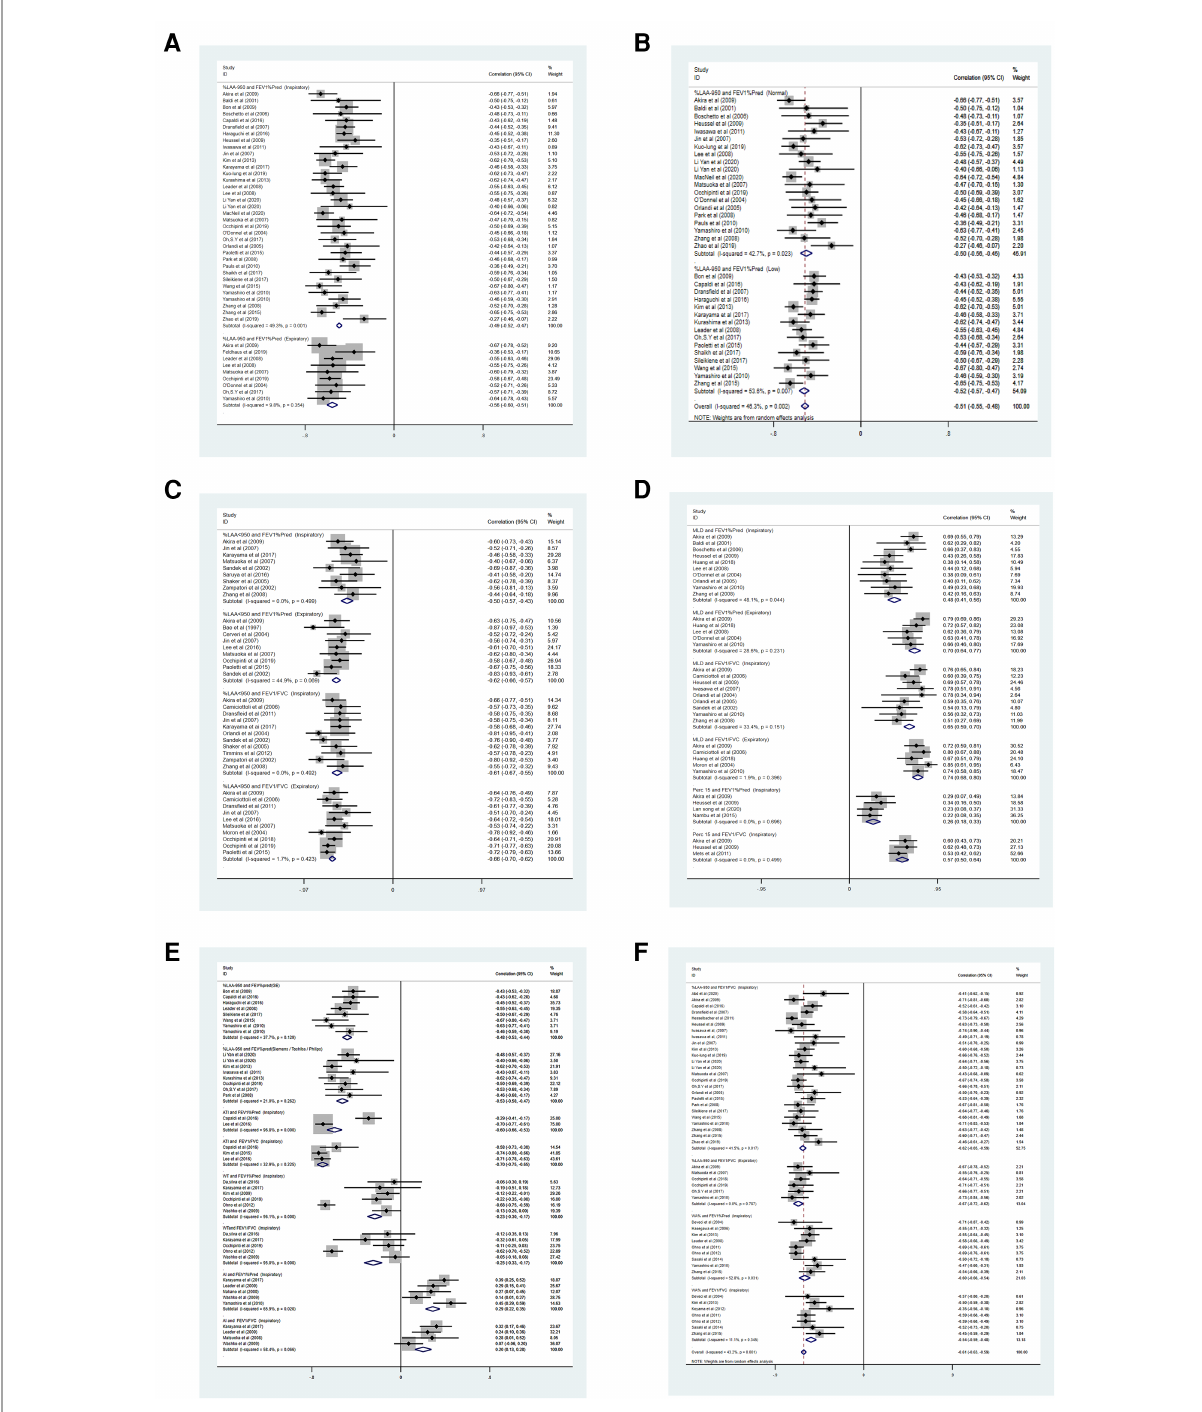
FIGURE 4 ( A – F ) Forest plots for correlations between CT measurements and air fl ow obstruction. CCI, con fi dence interval; P ( Z )= P value of Z test; FEV1%pred, percentage of the predicted forced expiratory volume in the fi rst